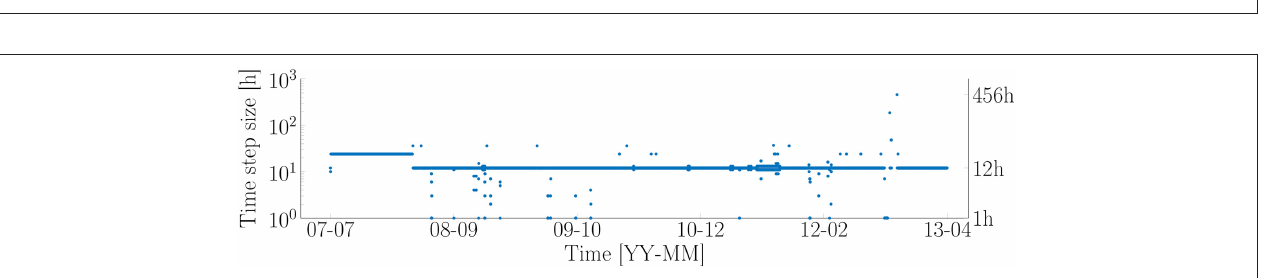
FIGURE 8 | Piezometric pressure under a dam in Canada.